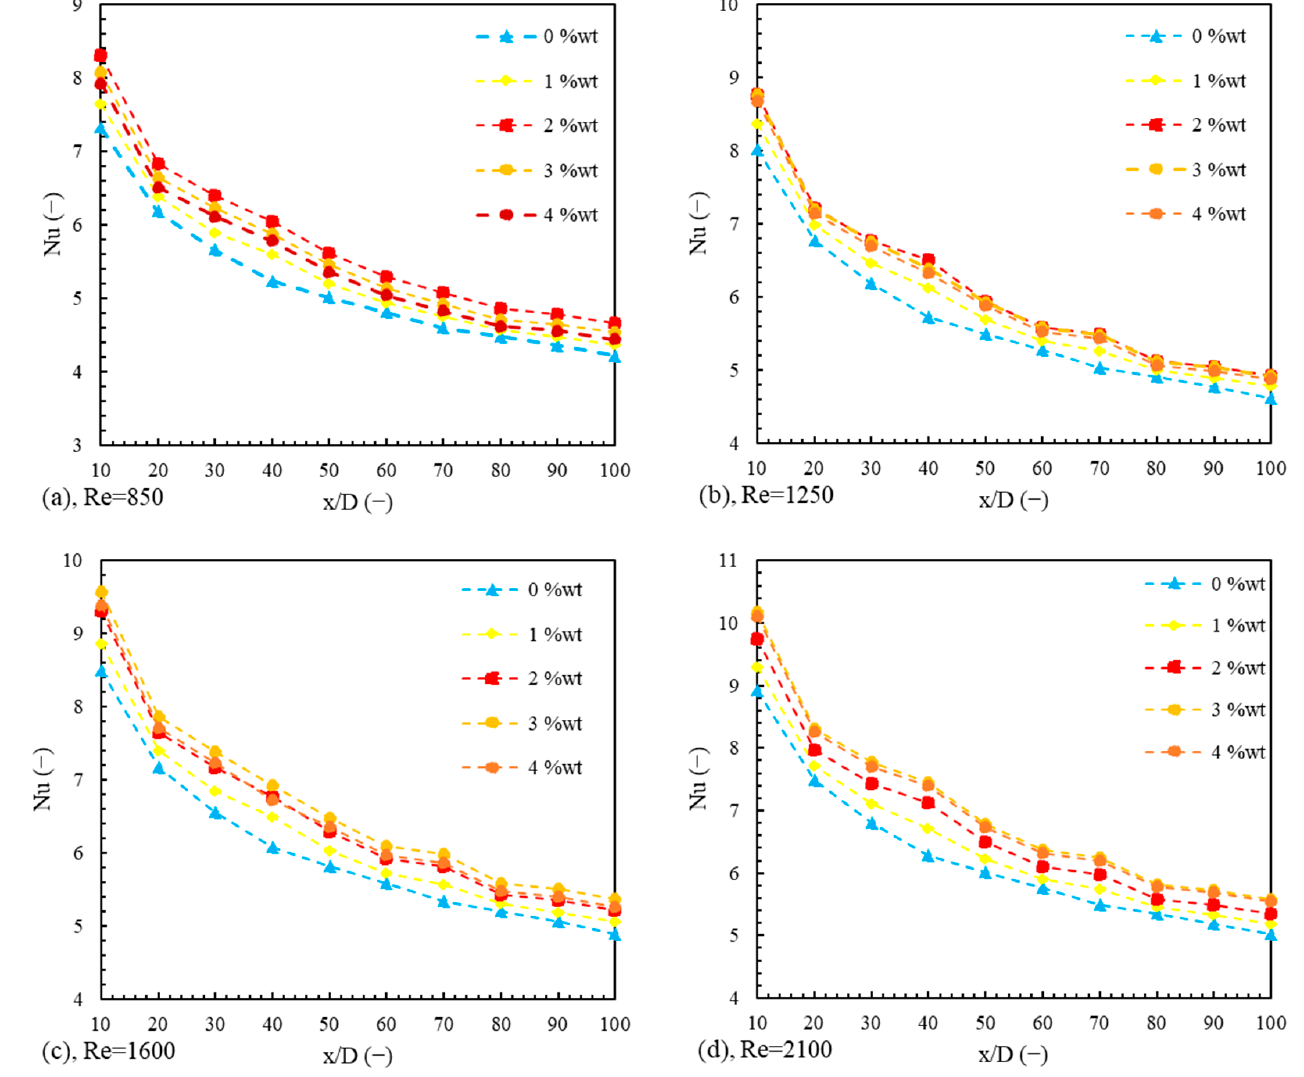
Figure 10. The results of local Nu for rectangular cross-section with different nanoparticle concentrations in ( a ) Re = 850, ( b ) Re = 1250, ( c ) Re = 1600, and ( d ) Re = 2100.